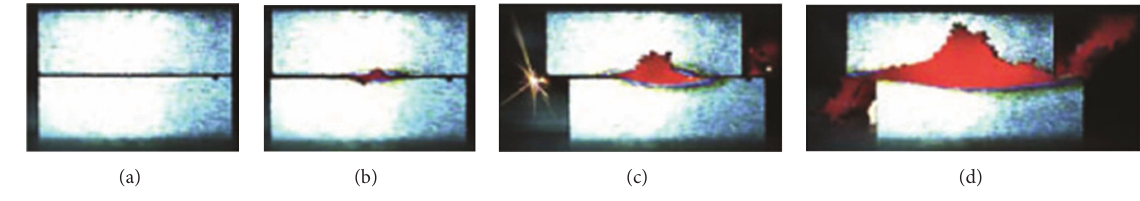
Figure 4: High-speed photography of a titanium alloy linear friction weld